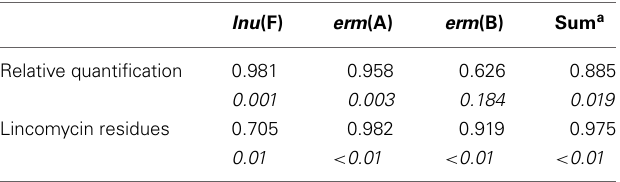
Table 1 | Correlation analysis of lincomycin-resistance genes in paired water and soil samples as well as correlation between lincomycin- resistance genes and lincomycin